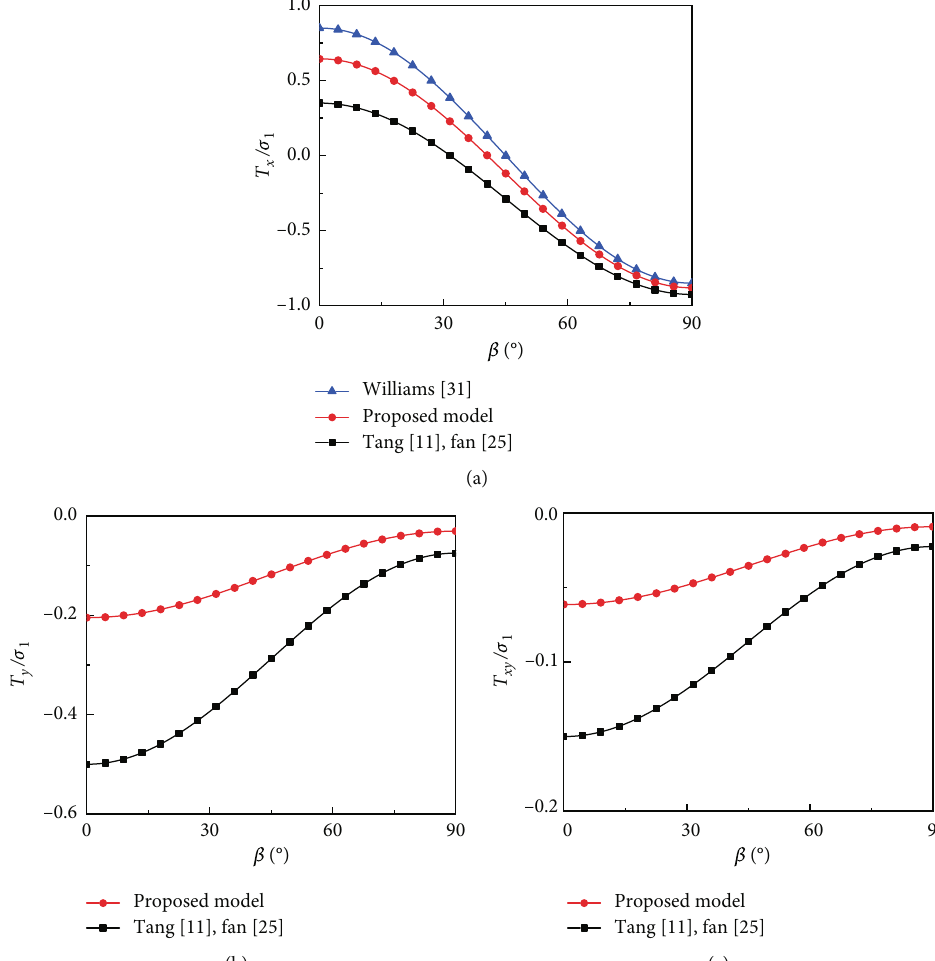
Figure 12: Comparison of the variation of normalized T -stress components as a function of crack inclination angle obtained from the proposed and the previous theories: (a) T